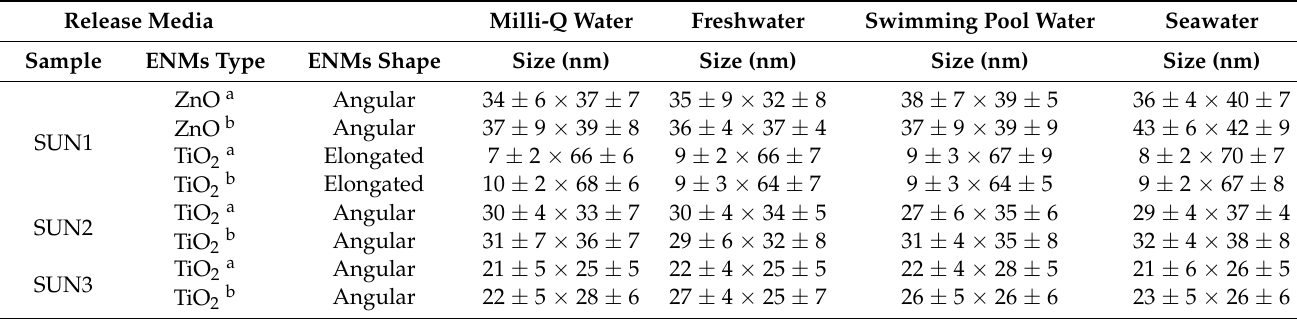
Table 1. Particle shape and the average size of product-released ENMs in different release water media. a and b are the sizes of product-released ENMs obtained under light and dark conditions,